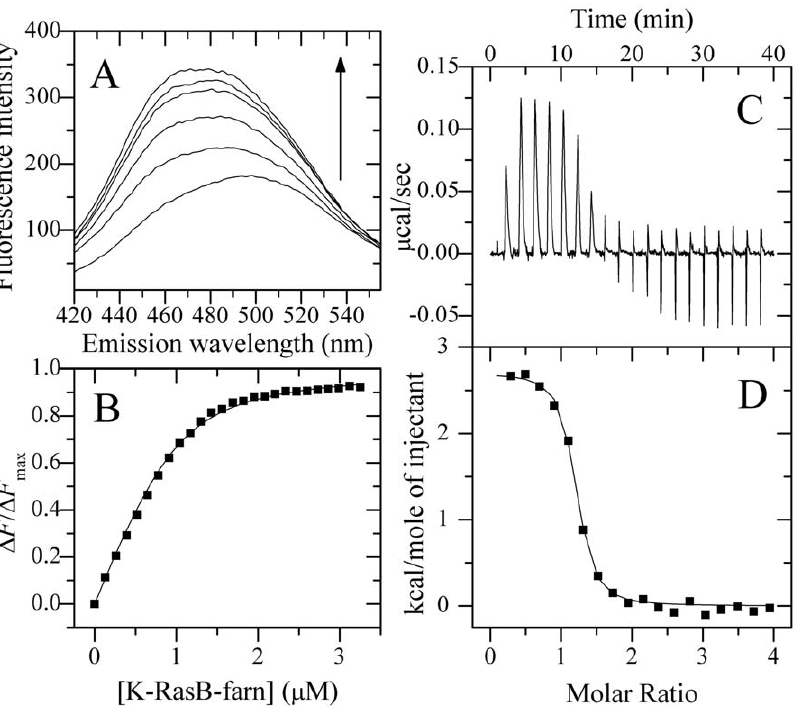
Figure 5. Interaction of farnesylated K-RasB with Ca 2 + /CaM at 25.0 6 C. Fluorescence spectra (A) of 1.0 m M dansyl-CaM in the absence and in the presence of GppNHp bound K-RasB-farn at different concentrations. The arrow represents the concentration of K-RasB-farn increases gradually from 0 (the bottom) to 3.3 m M (the top). D F / D F max for the binding of K-RasB-farn to Ca 2 + /CaM plotted as a function of the concentration of K-RasB- farn (B). The solid squares were the experimental data and the solid line represented the best fit. The panel C represents typical calorimetric titration of K-RasB-farn (30.0 m M) with CaM (600 m M) in the presence of 1 mM CaCl 2 . The panel D shows the plots of the heat evolved (kcal) per mole of CaM added, corrected for the heat of CaM, against the molar ratio of CaM to K-RasB. The data (solid squares) were fitted to a single set of identical sites model and the solid line represented the best fit. The corresponding parameters from B and D are summarized in Table 1.